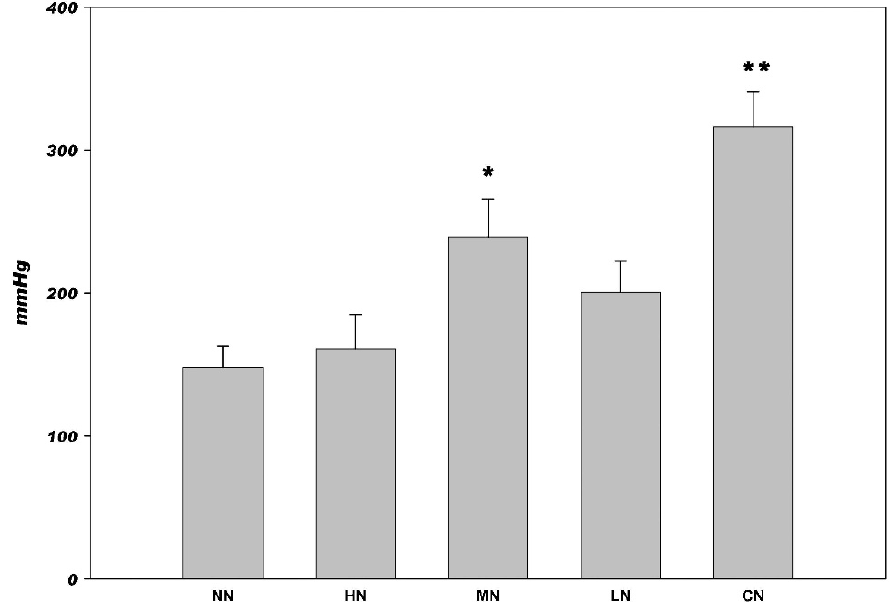
Figure 2 - Bursting pressure in non-ischemic (low-risk) colon anastomoses in rats. * p , 0.05 vs. NN, HN, and CN. ** p , 0.01 vs. NN, HN, and